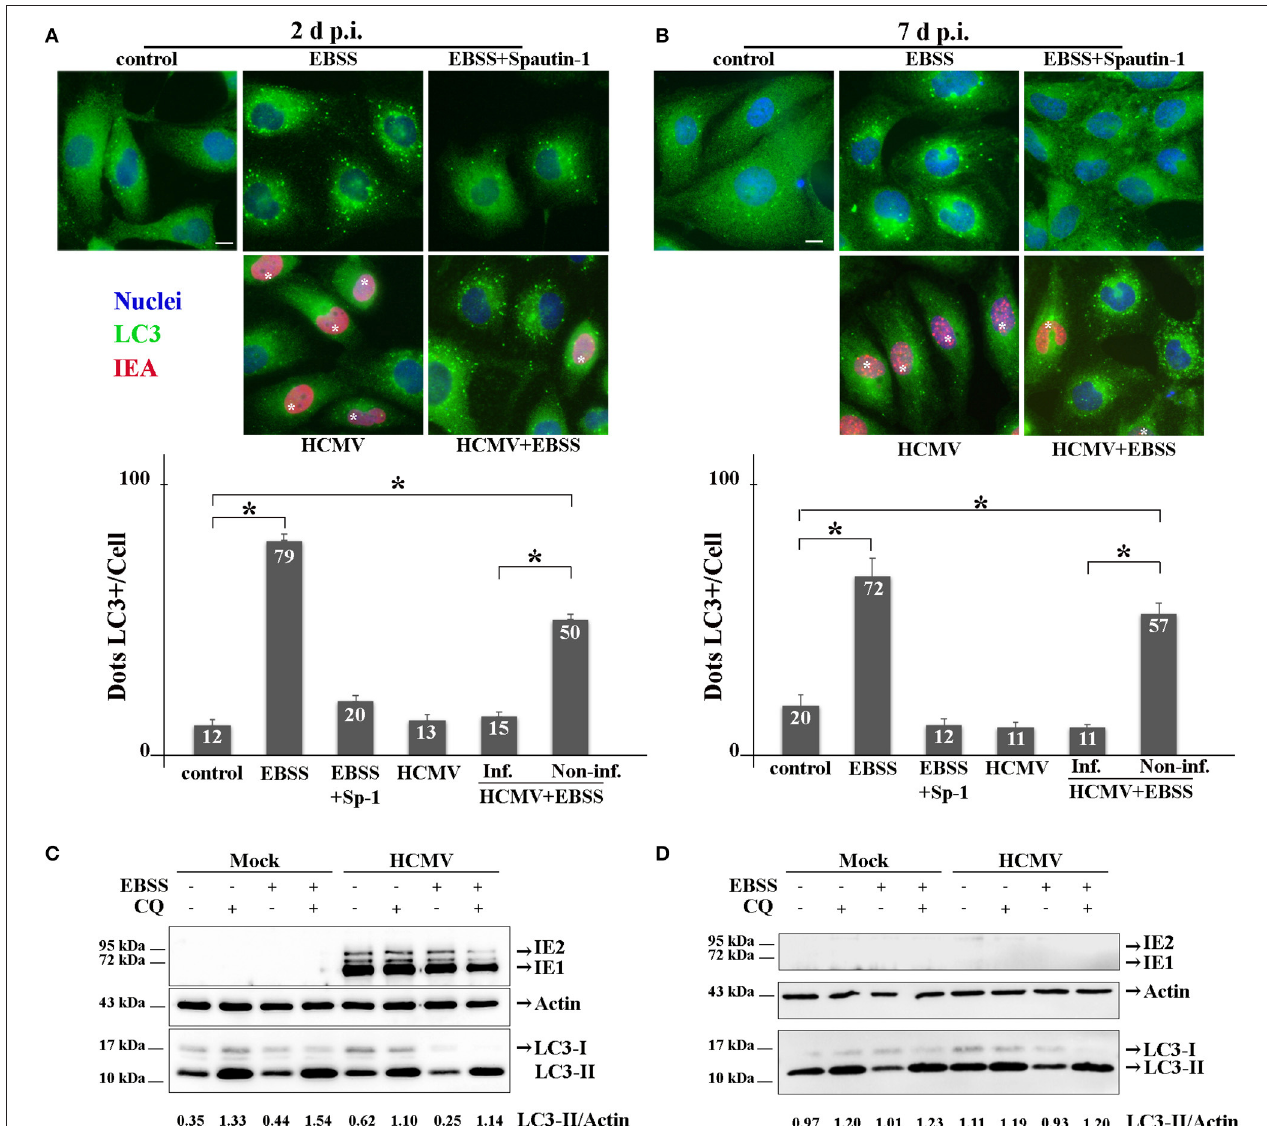
FIGURE 3 | HCMV inhibits the autophagic process. (A,B) Representative images of HK-2 cells treated or not (control) with EBSS (to induce autophagy) or treated with EBSS + Spautin 1 (to block starvation-induced autophagy). HK-2 cells were also infected with HCMV at MOI 1 (and treated with EBSS for the 4 last h of infection or not). Cells were fixed after 2 days (A) or 7 days (B) and immunostained for LC3 (autophagosome marker, green) and IEA (viral protein, red). Nuclei were subsequently stained with DAPI. Scale bars represent 10 µ m. Infected cells are marked with *. Quantification of LC3-positive dots per cell in each condition (lower panels). In HCMV + EBSS condition, cells expressing IEA (inf.) and neighboring non-infected cells (non-inf.) were analyzed separately. * p < 0.05 (ANOVA, with a Tukey contrast). (C,D) Immunoblot analysis of IEA and LC3-I and II in mock- or HCMV-infected HK-2 cells (2 and 7 days p.i.). Cells were treated when indicated for 4h